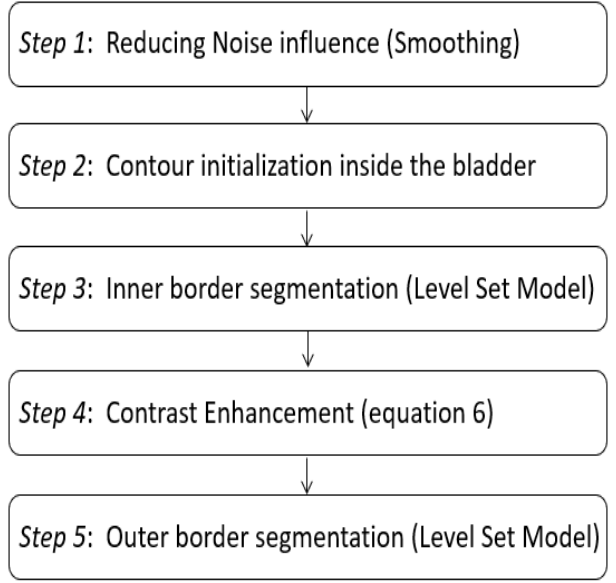
Figure 2. Overview of the full proposed segmentation procedure.